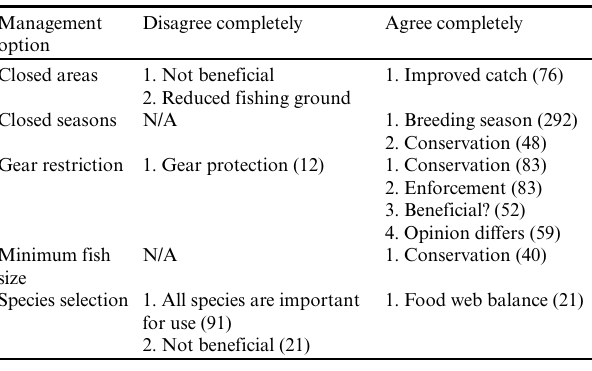
Table 4. Common reasons for agreement and disagreement with various management options. Number of responses is in